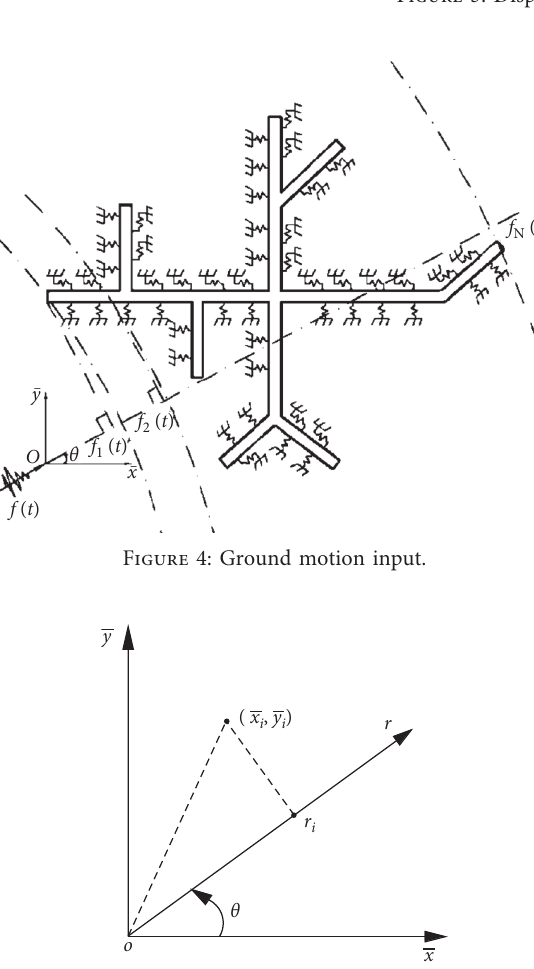
Figure 5: Projection of pipe coordinates to the propagation